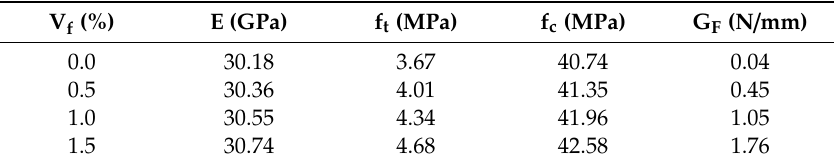
Table 2. Simulated elastic and inelastic properties for SFRC at di ff erent fiber volume fractions. V f (%) E (GPa) f t (MPa) f c (MPa) G F (N /